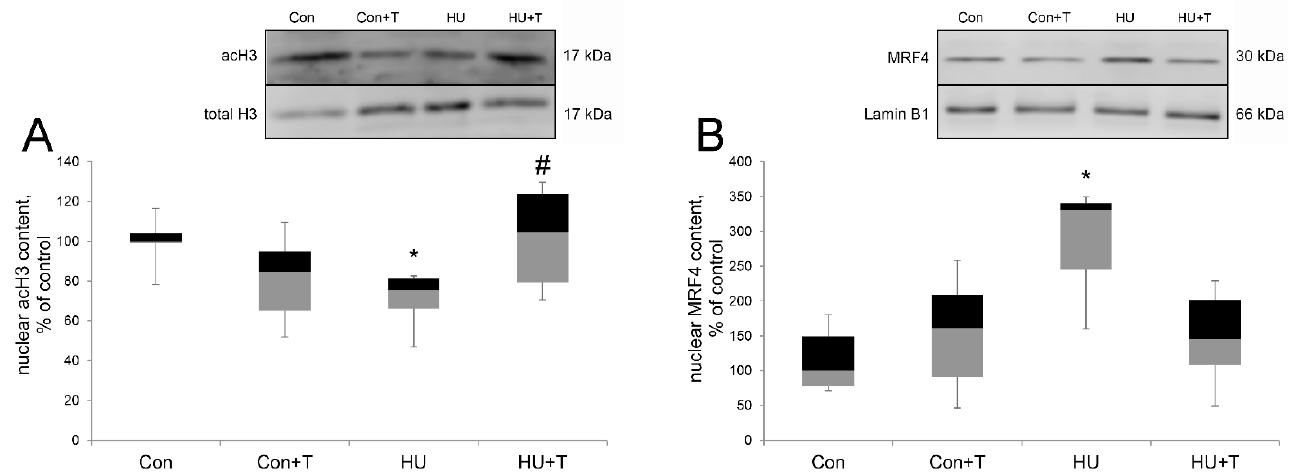
of the control group. *—significant difference from the control group. #—significant difference from HU group ( p < 0.05). Box plots show 25–75 percentiles and median values and the whiskers represent the minimum and the maximum; n = 8/group.